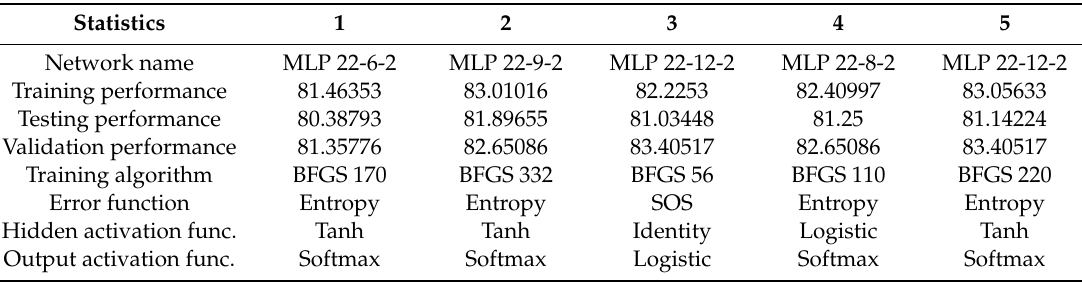
Table 4. Retained neural networks.